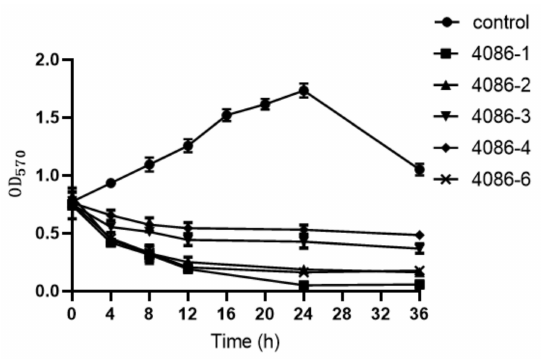
Figure 7. The effects of the isolated phages on the removal of the S. aureus biofilms. Bacterial biofilm formation was measured at various time points.